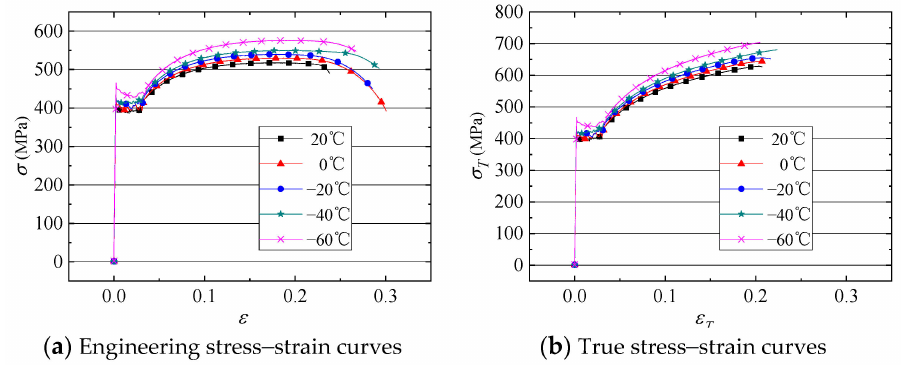
Figure 5. Stress–strain curves of EH36 at different